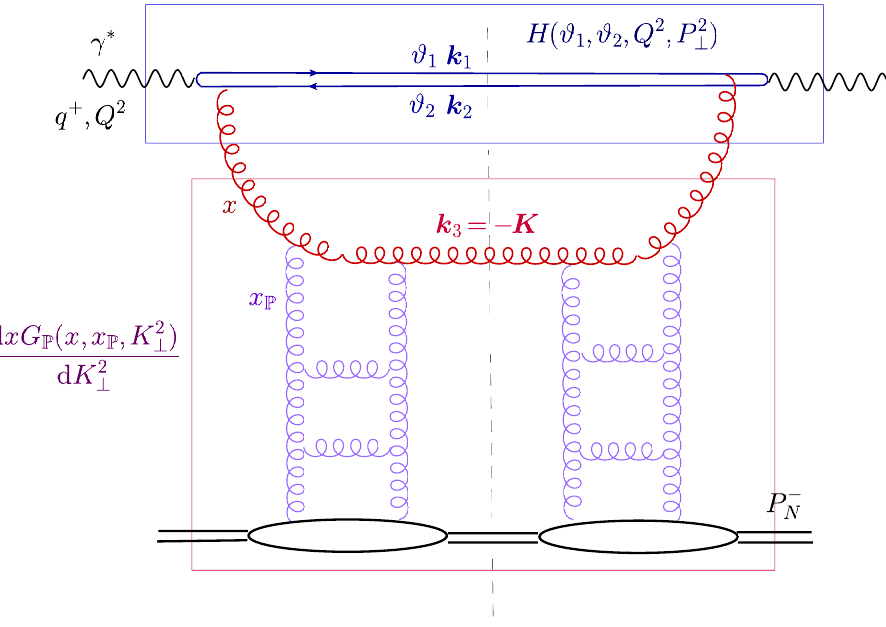
Figure 5 . Graphical representation of the TMD factorisation for diffractive 2+1 jet